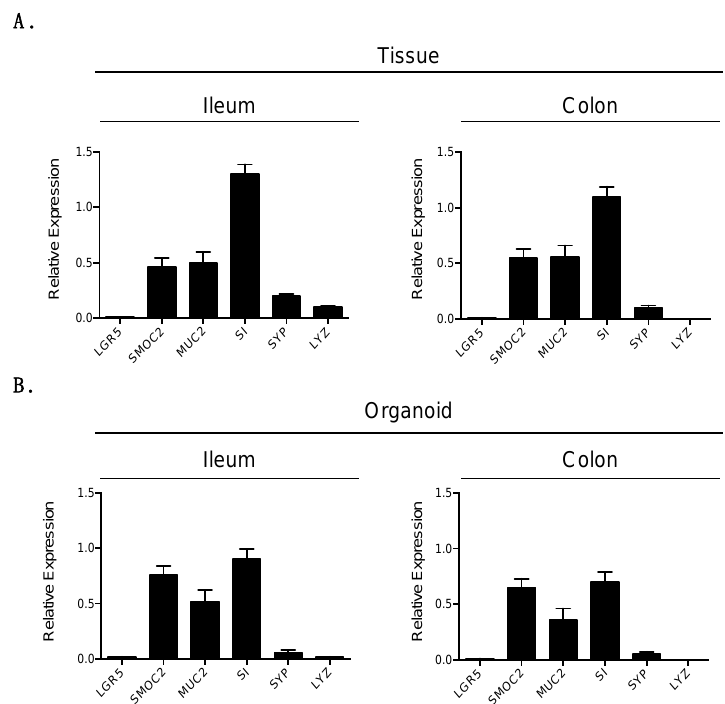
Figure 2. Feline organoids and originating tissue contain similar cell types. ( A ). The relative expression of intestinal cell type specific markers was evaluated in feline ileum and colon tissue by q-RT-PCR. ( B ). Same as A except using feline ileum- and colon-derived organoids. Results are mean +/ − s.d. and are expressed as a relative expression to the house-keeping gene GAPDH. n = 3 donors and q-RT-PCR was done as technical triplicate.